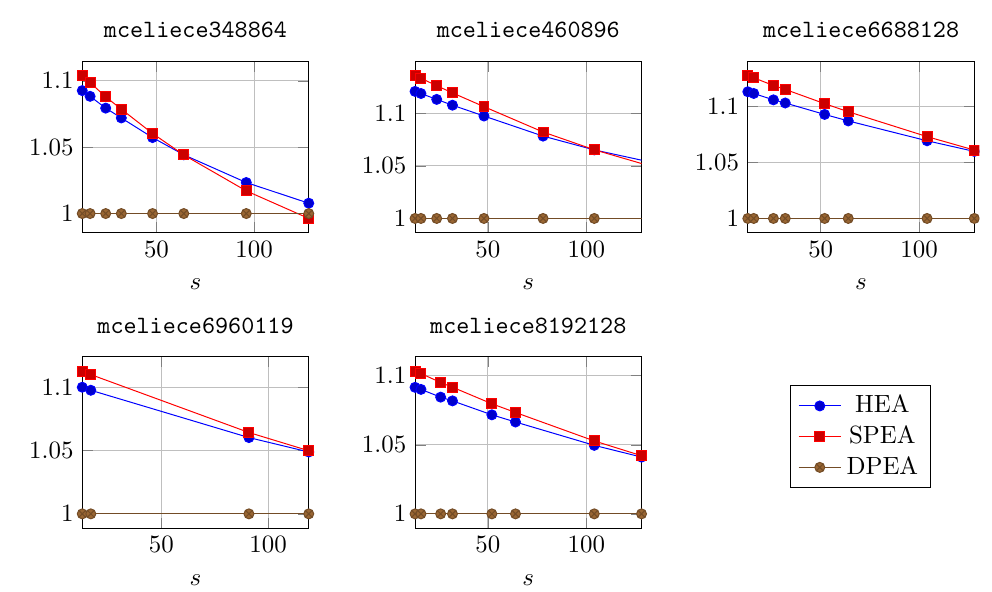
Figure 16: Speed (in terms of cycle count) of public-key generation using our three systemizers HEA, SPEA, and DPEA relative to DPEA for different s for the param- eter sets mceliece348864 , mceliece460896 , mceliece6688128 , mceliece6960119 , and mceliece8192128 . Compared to DPEA, [WSN16] and [WSN18] (omitted in the graphs) are about three times slower for all s and all parameter